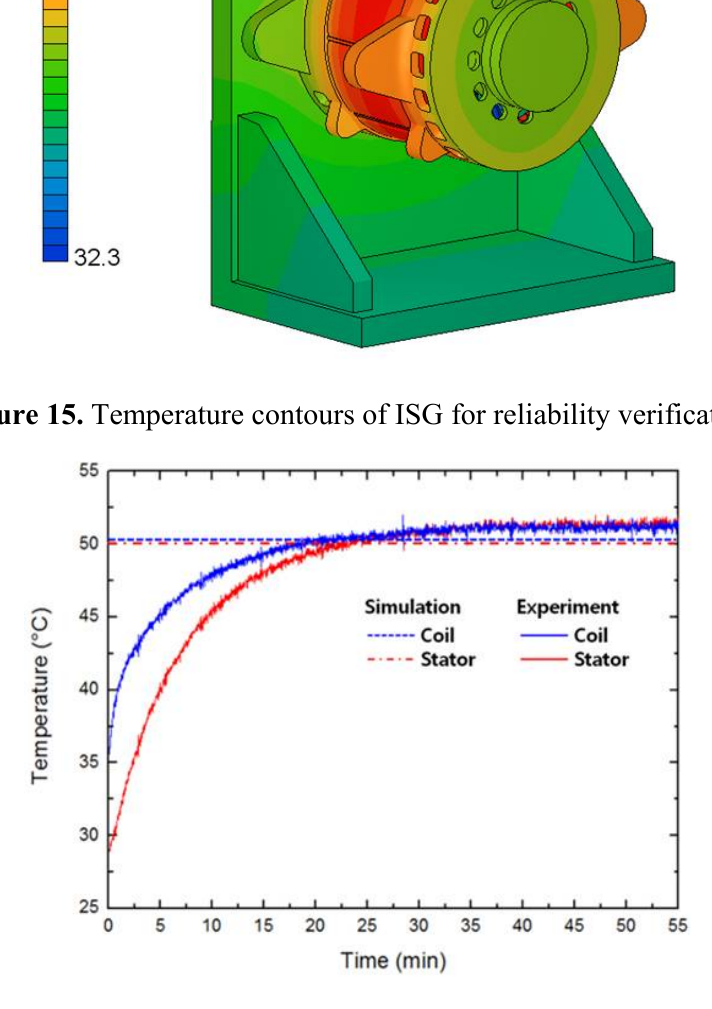
Figure 16. Comparison of analysis and experimental